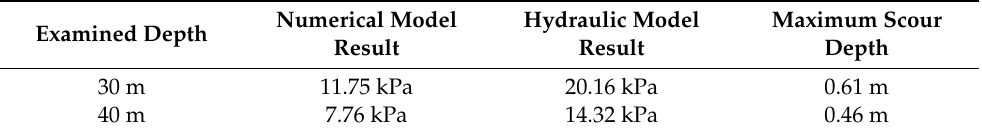
Table 8. Details of the wave pressure measurement